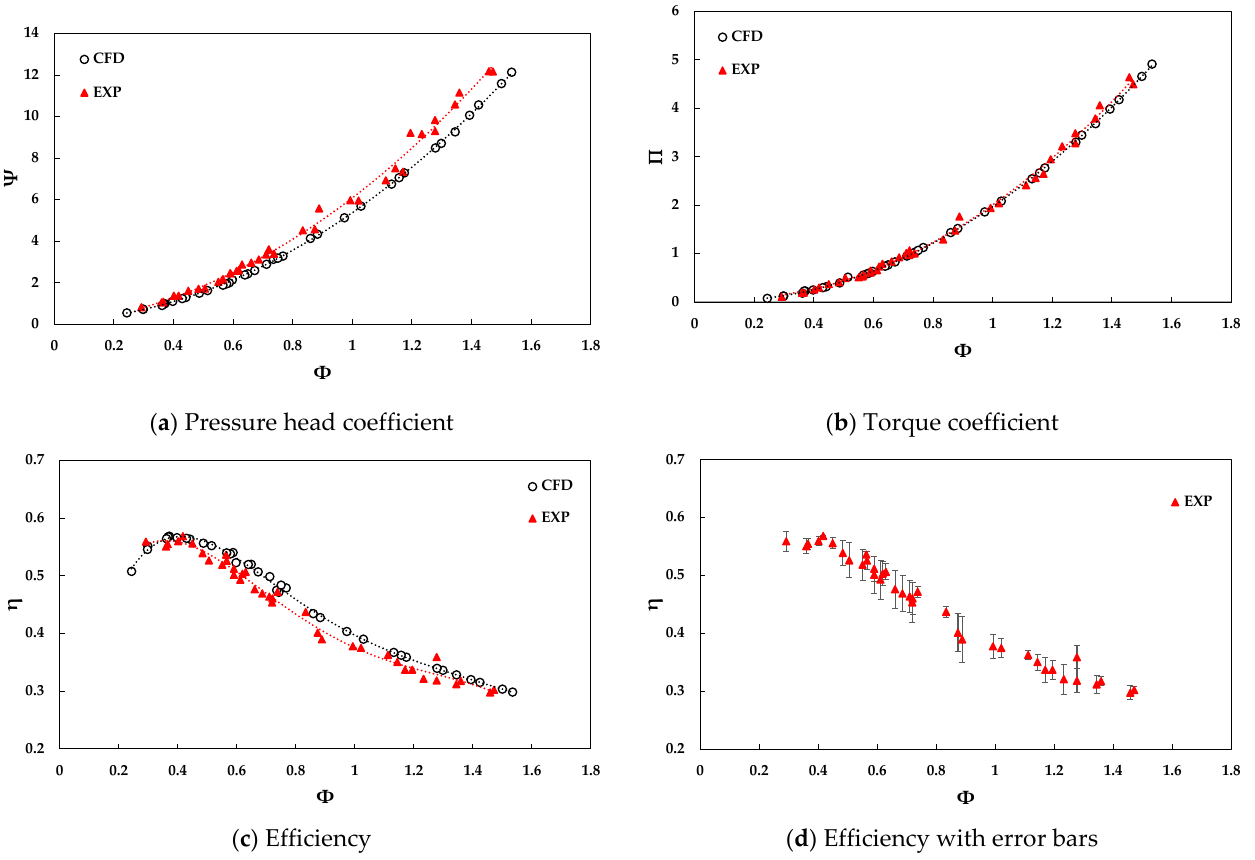
Figure 13. Comparison of the cycle-averaged performance of numerical and experimental turbines in reciprocating air flows.